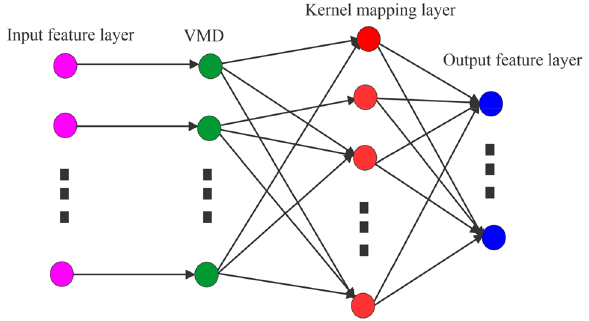
Figure 1. Implementation of VMD-KELM forecasting algorithm with input and output